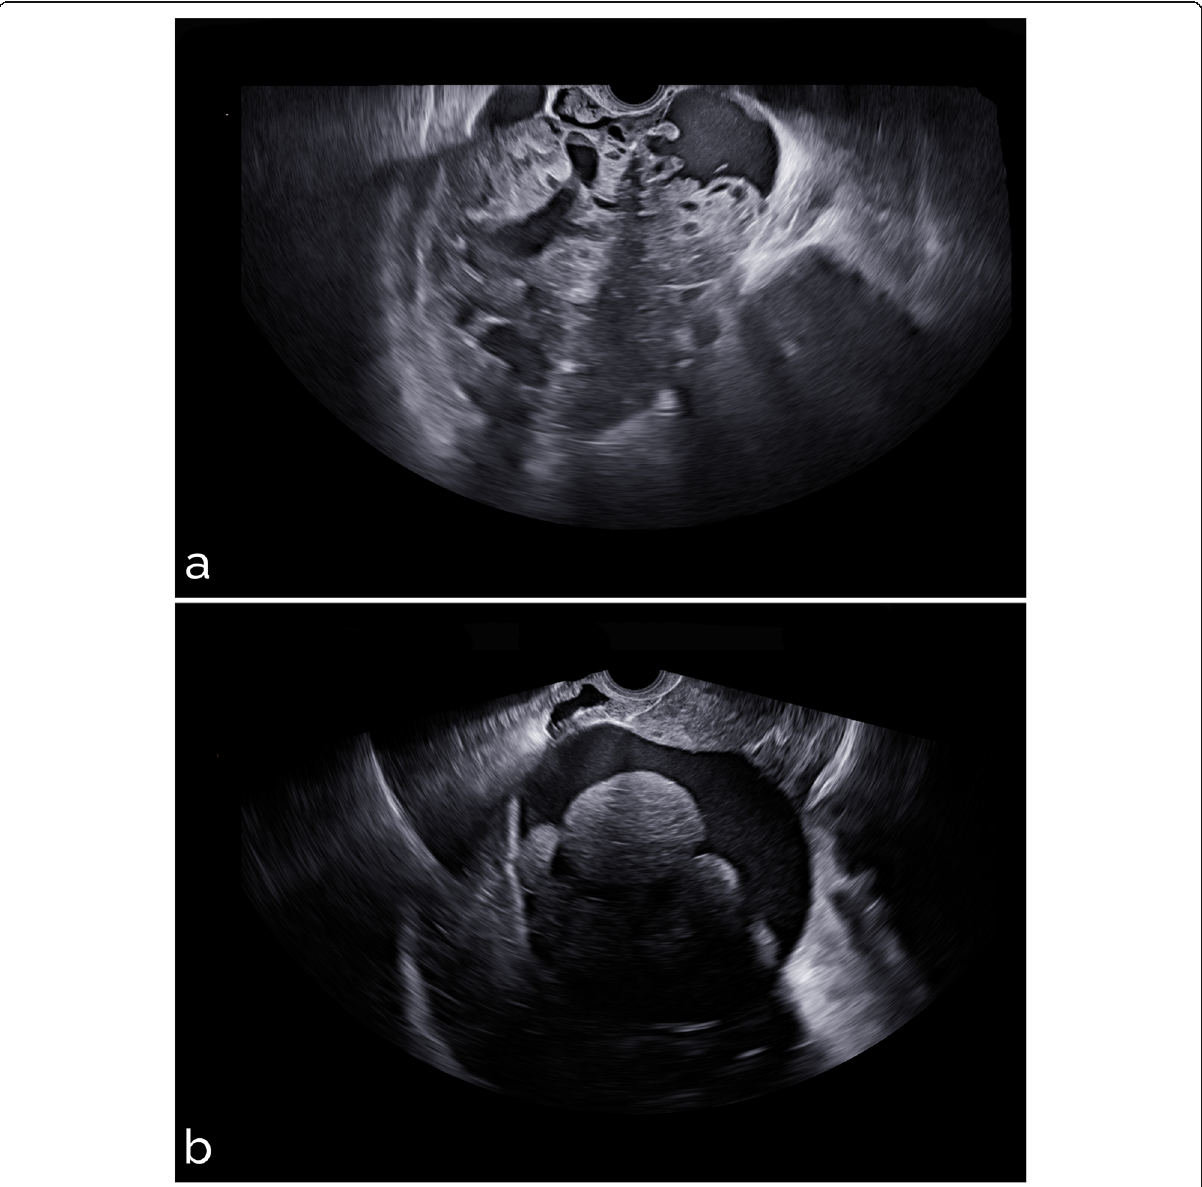
Fig. 5 Transvaginal ultrasound of ovarian masses with acoustic shadows: ( a ) solid mass with acoustic shadows, CA125 205 IU/mL, immature teratoma on histological examination (medium-high risk), ( b ) mixed adnexal mass with acoustic shadows, benign teratoma on histological examination (very low